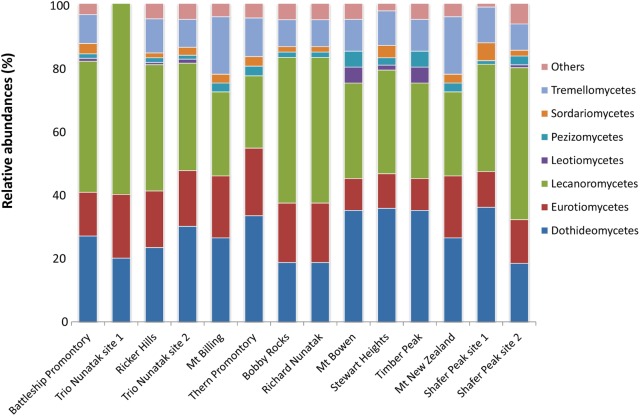
Relative abundances of the dominant fungal OTUs in the cryptoendolithic communities in Victoria Land, Antarctica. All relative abundances are based upon sequences identified at the class level. Others include classes Agaricomycetes, Microbotryomycetes, Saccharomycetes, Taphrinomycetes, and Cystobasidiomycetes, with relative abundances ≤ 5%.